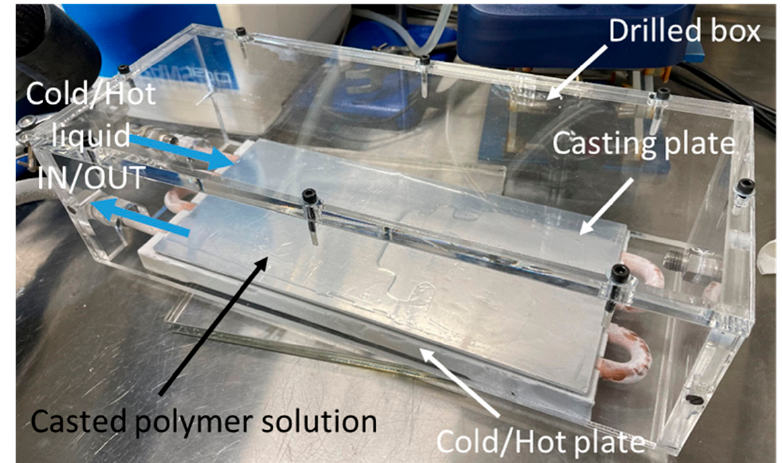
Figure 2. Membrane Figure 2. Membrane preparation.